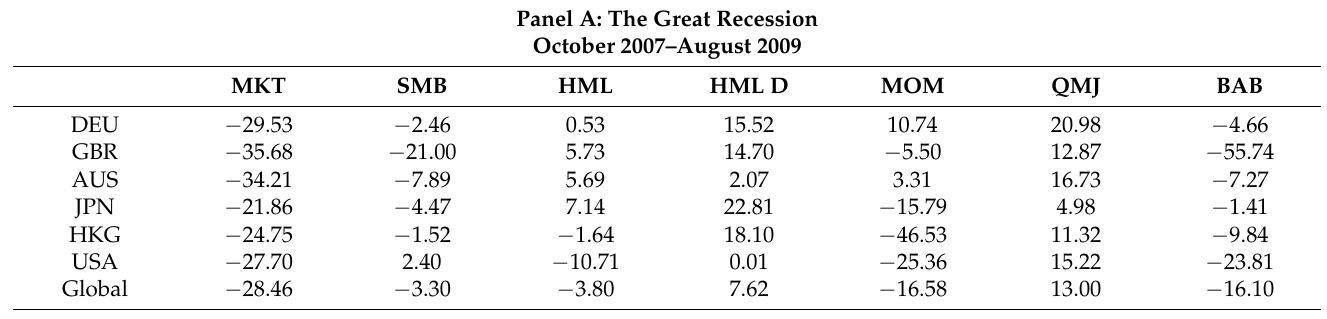
Table 6. Annualized Minimum Cumulative Return. Panel A: The Great